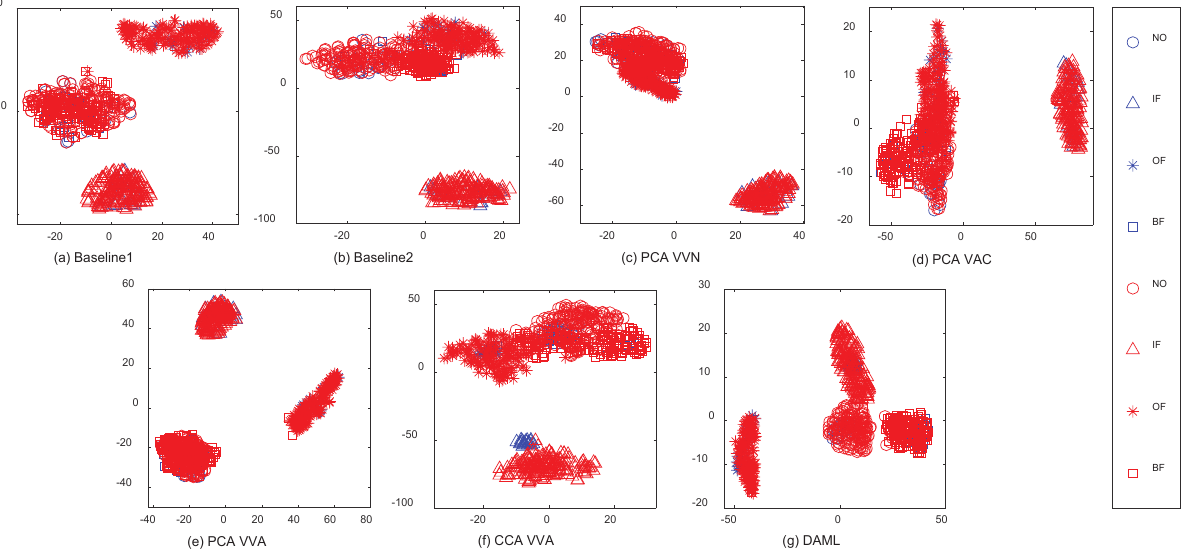
Figure 8. Feature visualization via t − SNE [43] of a multi-view fault diagnosis task, ( a ) Baseline 1,